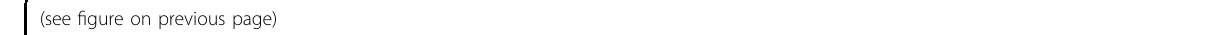
emerging as potential host virus-restricting factors. a Experimental approaches for transcriptomic and translatomic pro fi ling of host genes upon transfection with the Cre-based rcccDNA system of HBV. b The cumulative TE distribution among HBV groups and control groups, host genes were translated less ef fi ciently in HBV groups than that in control groups. P -values for comparison between each of the HBV and control group were calculated using Kolmogorov – Smirnov test with the results shown on the top. c Heatmap and d GO annotation of the 35 ttDEGs, whose expression was signi fi cantly altered by HBV in both transcription and translation. e RT-qPCR reveals that HBV downregulated the transcriptional level of endogenous PGAM5 and upregulated PPP1R15A transcription. f , g Reinstatement of the static levels of two representative ttDEGs affected the expression of cellular HBcAg ( f ) and secreted HBsAg and HBeAg ( g ). The major bands were marked with asterisks to indicate the theoretical molecular weights of the ectopically expressed ttDEGs. * P < 0.05, ** P < 0.01, *** P < 0.001. ELISA data are presented as bar chart ( n = 3); qPCR results are presented as bar chart ( n =